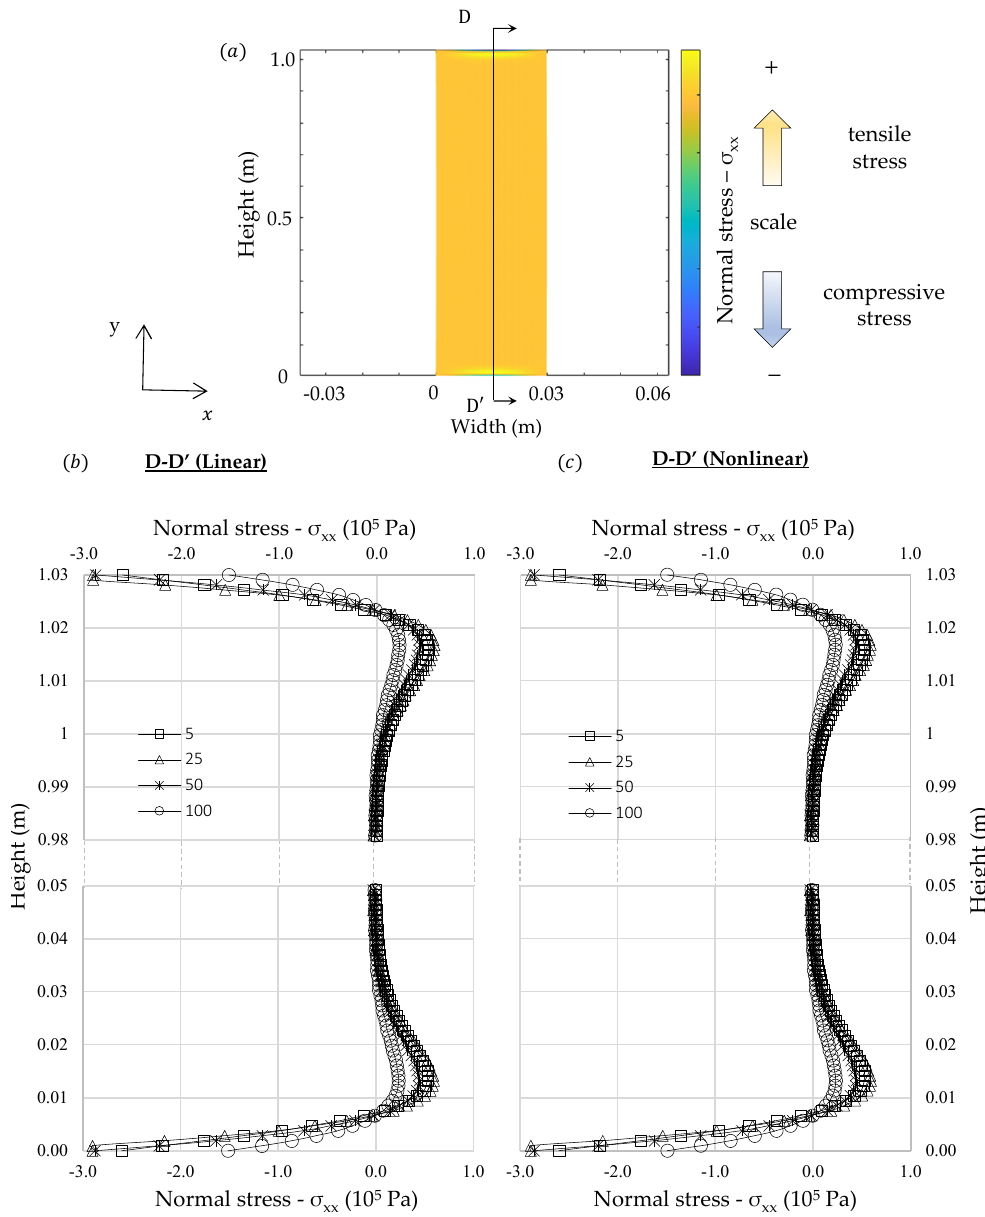
Figure 7. Comparison between linear and nonlinear numerical analysis of σ xx : (a) Representation of a generic normal stress distribution (b) linear analysis (c) nonlinear analysis.